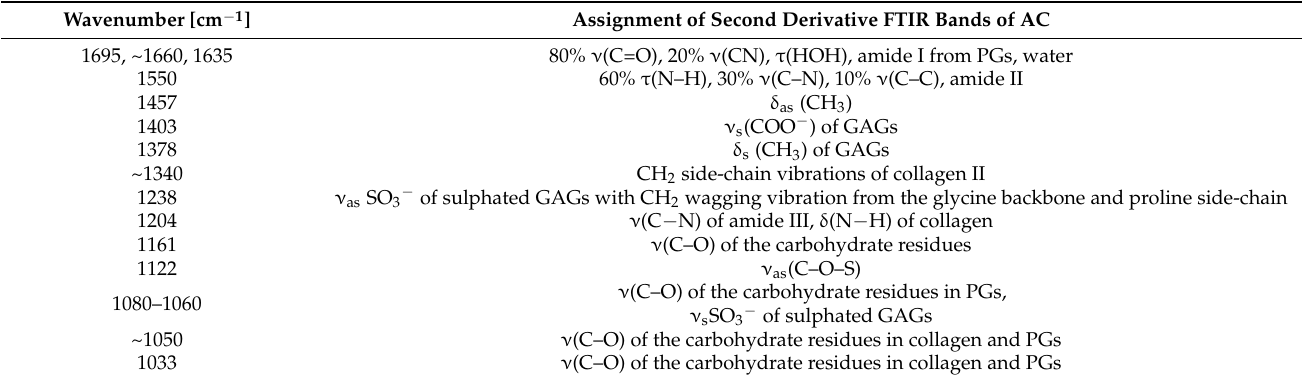
Table 1. The most significant bands obtained from the second derivative FTIR spectra. An assignment of spectral features was collected according to the literature